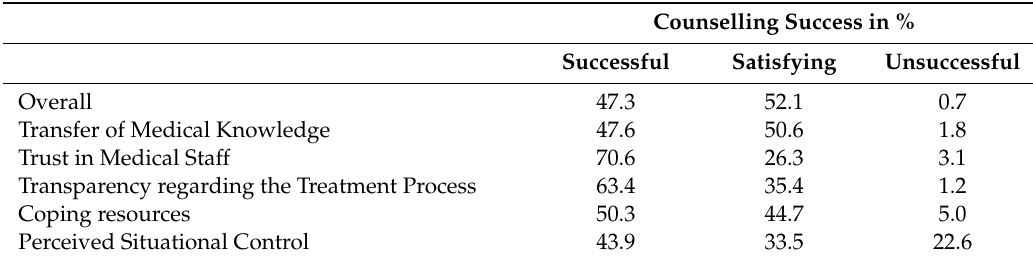
Table 2. Overall counselling success and in the five created analytical dimensions.